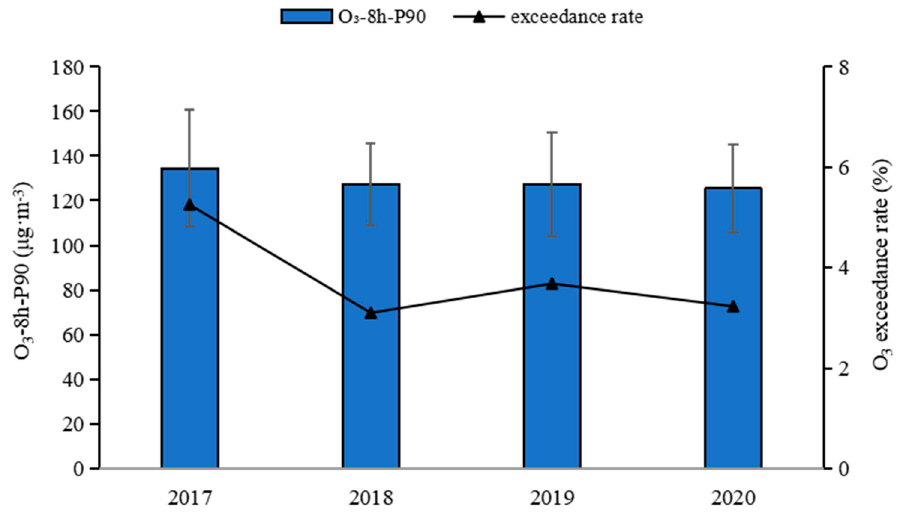
Figure 2. Variations in O 3 ‐ 8 h ‐ P90 and the over ‐ standard rate from 2017 to 2020 in Northeast